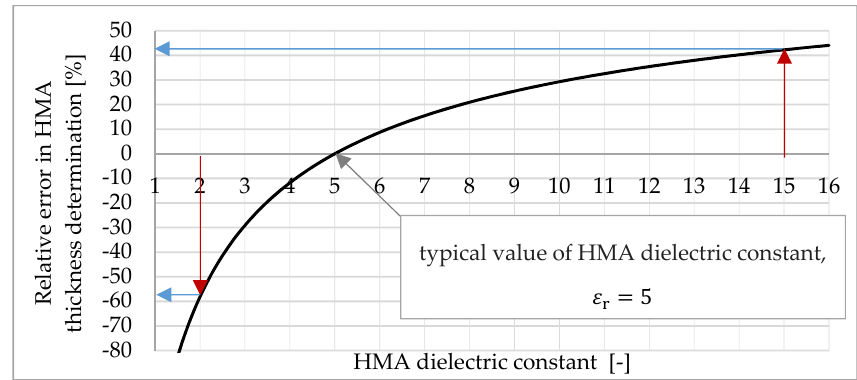
Figure 1. Impact of incorrect estimation of the dielectric constant of the asphalt mixture on the accuracy of thickness determination using the ground penetrating radar (GPR) method; blue arrows show the relative error in determining hot mix asphalt (HMA) thickness in situations when for HMA (22 cm thick and with an actual dielectric constant of 5), we incorrectly assume ε r = 2 or ε r = 15 (red arrows, the smallest / largest published HMA dielectric constant in the literature [18,20]).